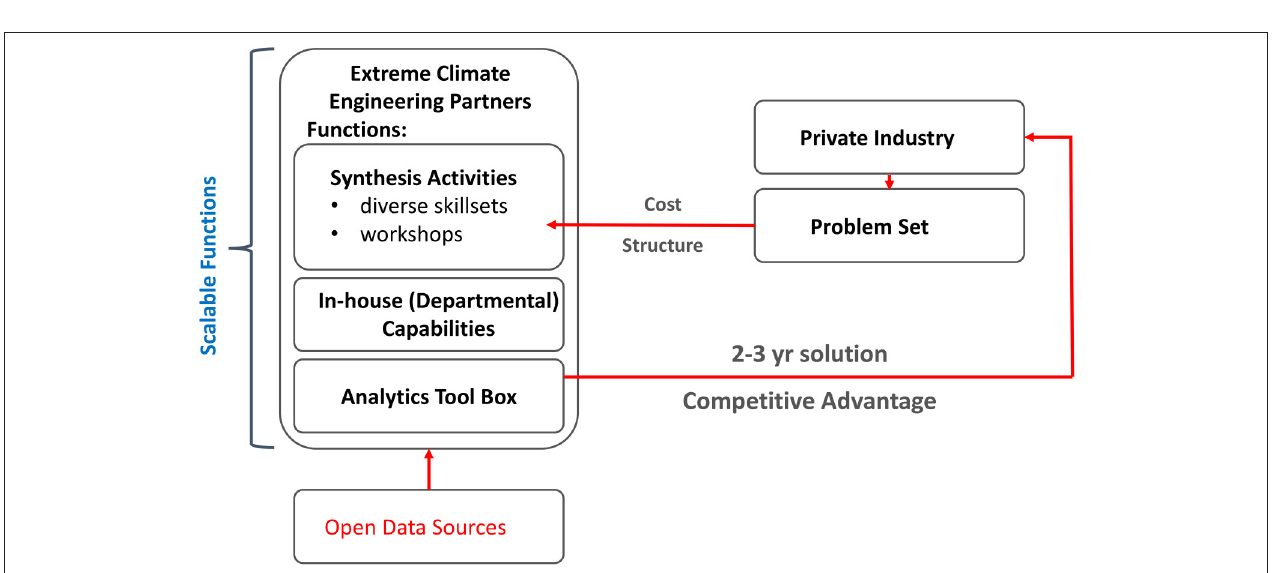
FIGURE 2 | The National Center for Atmospheric Research’s Engineering for Extreme Climate Partnerships value-added model (www.ncar.ecep.edu), with core, internal incubator functions on the left, and external activities on the right.